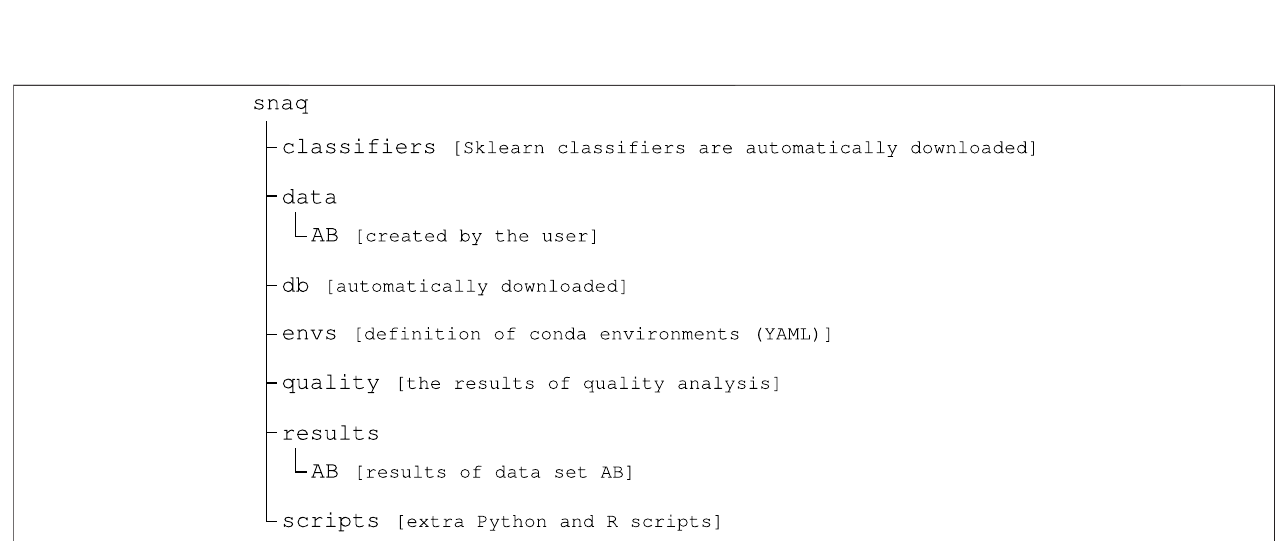
beta_braycurtis.tsv